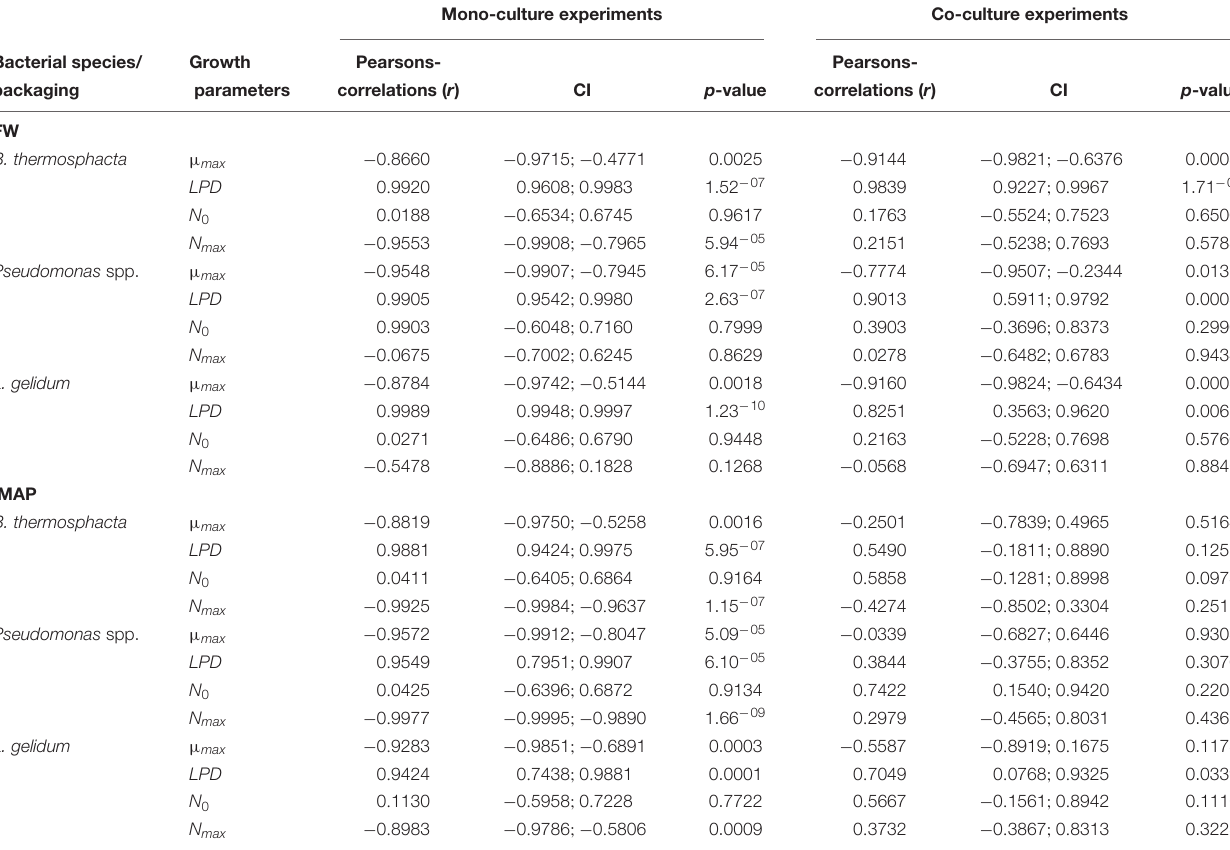
TABLE 6 | Correlations between growth parameters and the minimal shelf life ( MSL ) for mono-culture and co-culture experiments.